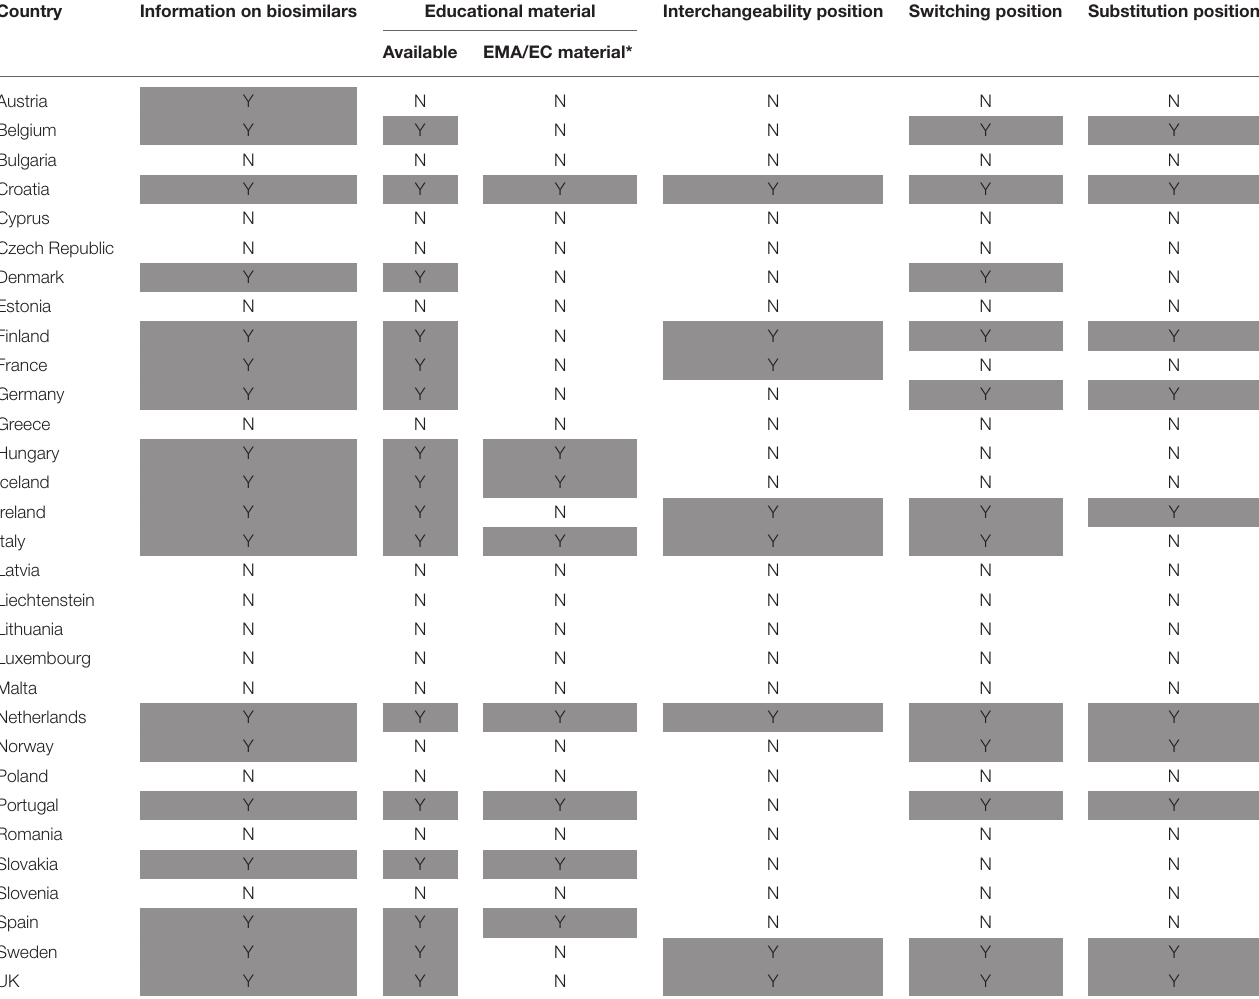
TABLE 1 | Overview of availability of biosimilar information and guidance provided by national medicines agencies.